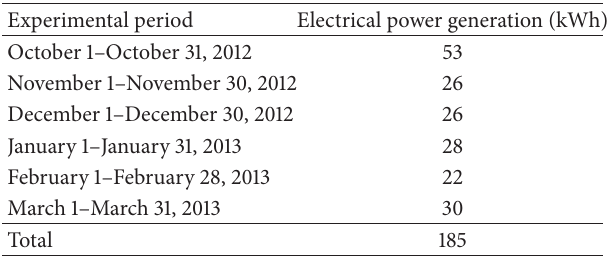
Table 6: Electrical power accumulation for the six-month experi- mental monitoring.